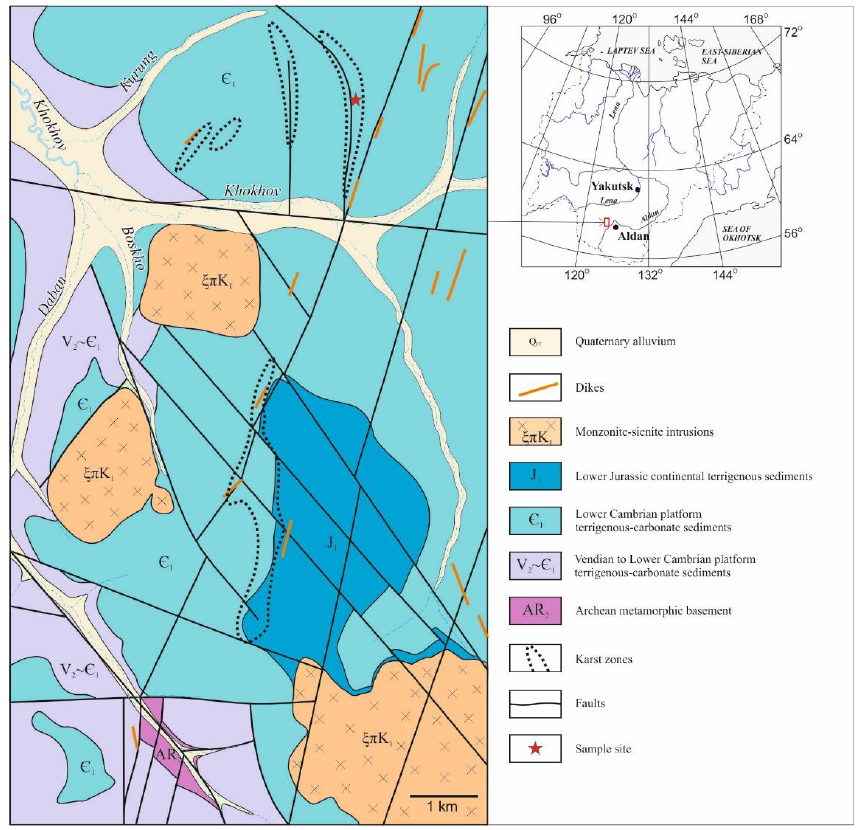
Figure 2. Geographical location and geological position and structure of Khokhoyskoe gold deposit [12].